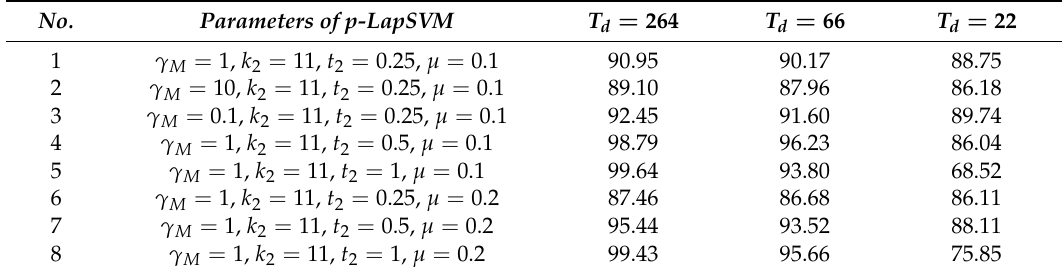
Table 2. Total classification accuracies under different parameters of p-LapSVM (time domain, (cid:96) e = 30, k 1 = 6, γ K = 10 − 6 , t 1 =